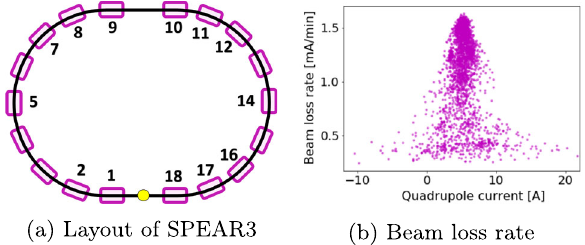
FIG. 1. (a) Layout of the SPEAR3 storage ring with the 13 free skew quadrupoles used for the online optimization of beam loss rate. The non-destructive current monitor is shown as a yellow dot. (b) Beam loss rate projected on a single skew quadrupole current. The data is taken from archived operations